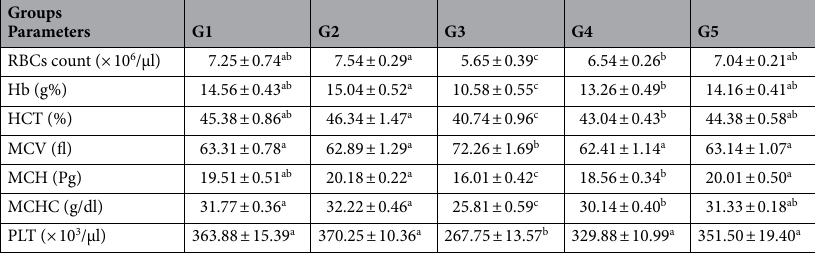
Table 2. Effect of thymoquinone supplementation and/or malathion inhalation on hemogram of rats. Values are expressed as mean ± standard errors. Means in the same row (a-b) with different subscript letters significantly differ at (p ≤ 0.05). RBCs red blood cells, Hb hemoglobin, HCT hematocrit, MCV mean corpuscular volume, MCH mean corpuscular hemoglobin, MCHC mean corpuscular hemoglobin concentration. G1 = control group, G2 = thymoquinone group (50 mg/kg body weight), G3 = malathion group G4 = malathion inhalation + thymoquinone 25 mg/kg body weight, and G5 = malathion inhalation + thymoquinone 50 mg/kg body weight.